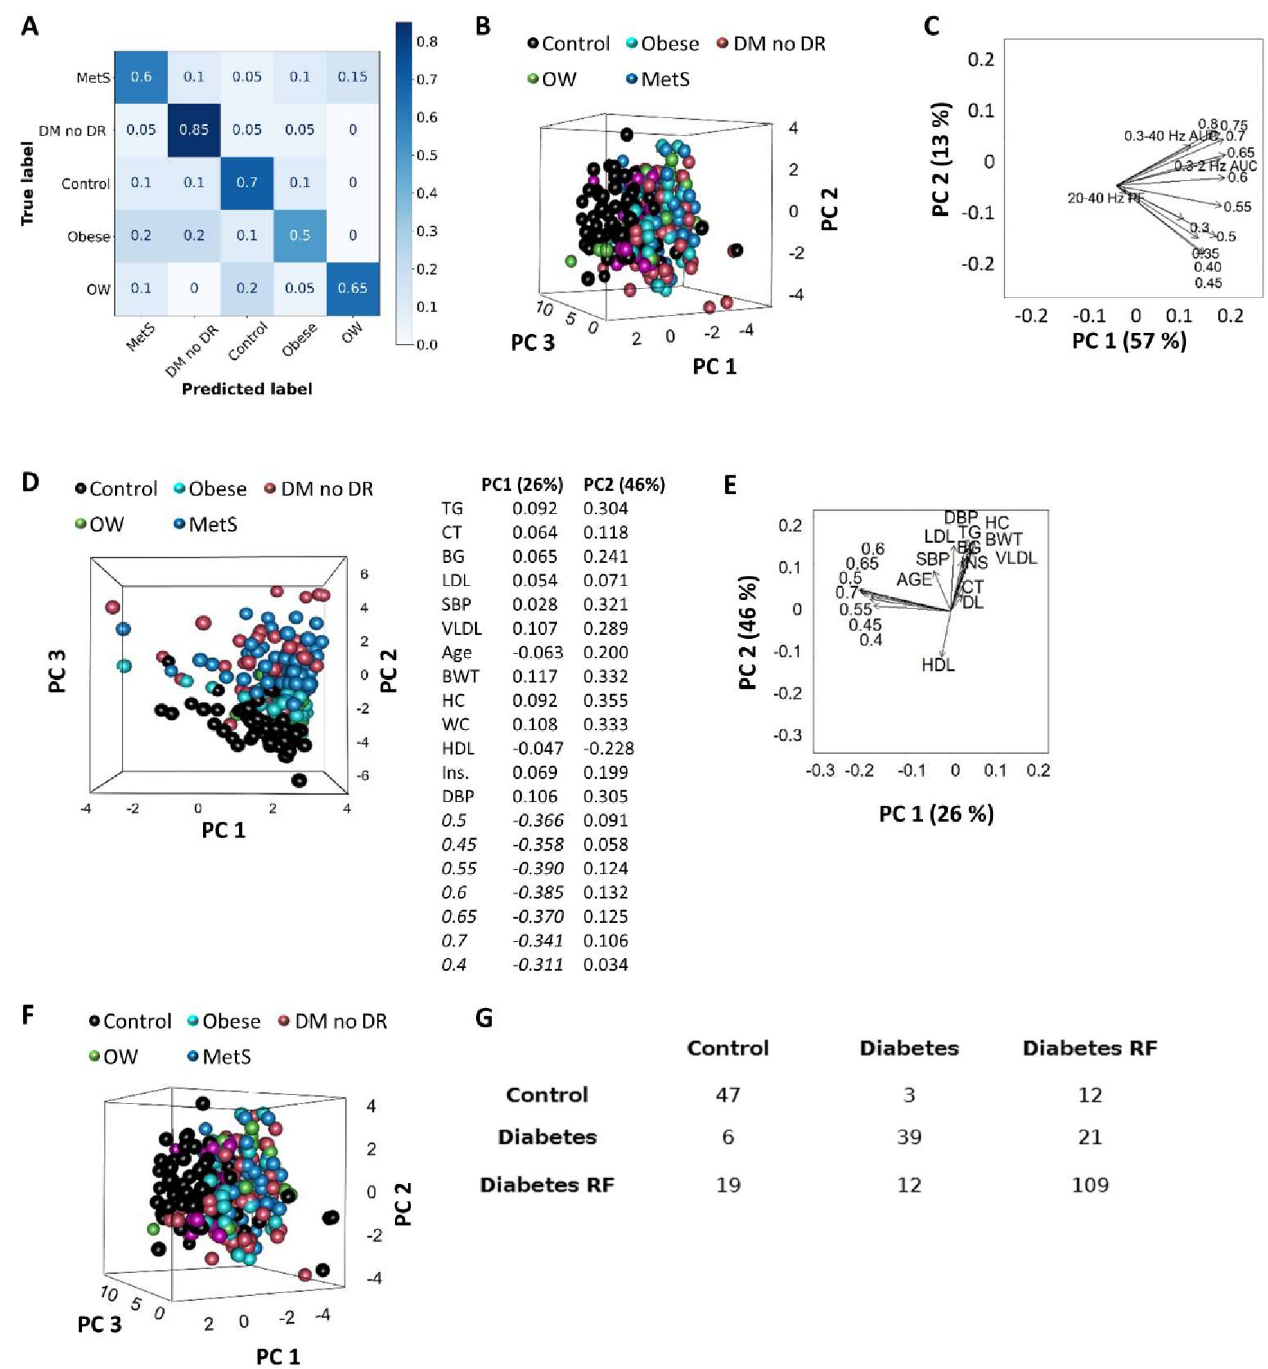
Fig 3. Multiclass prediction of people at risk of developing type 2 diabetes and DR using the spontaneous ERG-based random forest model: Explanatory data analysis. A, Multiclass confusion matrix for the prediction of control, overweight (OW), obesity, MetS, and diabetes with no DR (DM no DR) once the first binary classification (control vs. disease) was done using the Random Forest model. Data from Tables 1 and 2 were pooled and aleatory divided in a training (80%) and test (20%) set. B, Separation of control, overweight, obese, metabolic syndrome, and diabetes (DM) without DR cases using PCA and C, corresponding biplot of PC1 and PC2, using 13 variables: normalized power of the slowest oscillations (0.3–0.8 Hz), the AUC of the 0.3–40 Hz band (0.3–40 Hz AUC), and the peak frequency of the 20–40 Hz band (20–40 Hz PF). D, Separation of control, overweight, obese, metabolic syndrome, and diabetes (DM) without DR cases using PCA and E, corresponding biplot of PC1 and PC2, using 20 variables: normalized power of 0.4–0.7 Hz activities, TG, CT, fasting blood glucose (BG), LDL, systolic blood pressure (SBP), VLDL, age, body weight (BWT), hip and waist circumferences (HC and WC, respectively), HDL, insulinemia (Ins.), and diastolic blood pressure (DBP). Table (right) shows variable contributions to the first and second principal